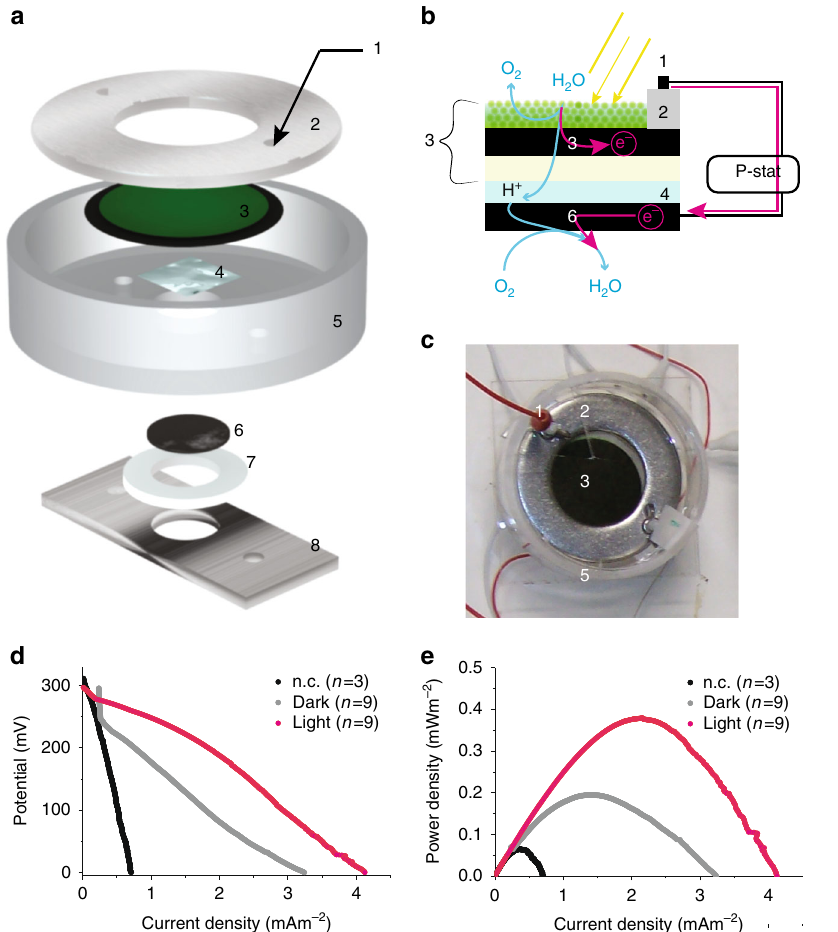
Fig. 2 Electrochemical characterisation of a digitally printed bioanode in a hybrid BPV system. a Schematic representation (semi-exploded view) of the BPV unit with printed paper-based anode. Clamping screws (component 1); marine grade stainless steel ring for contacting the CNT anode (component 2); printed CNT anode in black (Ø 60 mm) with printed photosynthetic organisms in green (Ø 40 mm) with a total area of ~ 28.4 cm 2 (component 3); hydrogel (component 4); Plexiglas vessel (component 5); carbon paper-Pt, with a total area of ~ 3.5 cm 2 was used as cathode (component 6); silicon O- ring (component 7); stainless steel plate used to clamp all the component together (component 8). ~ 60 ml of BG-11 medium was placed above the printed cells in the chamber formed by the top plate. b Schematic representation of the BPV unit cross-section where electrons, protons and oxygen fl ow are also shown. Numbering as in a . c Photograph of the experimental setup (excluding the potentiostat and the wiring). Numbering as in a . d Polarization and e power curves for the printed anode in the BPV unit. Printed Synechocystis (incubated for 5 days after printing) on printed CNT anode exposed to light (magenta symbols) and in the dark (grey symbol) was compared with a bare printed anode (black trace). Number of repeats is indicated in